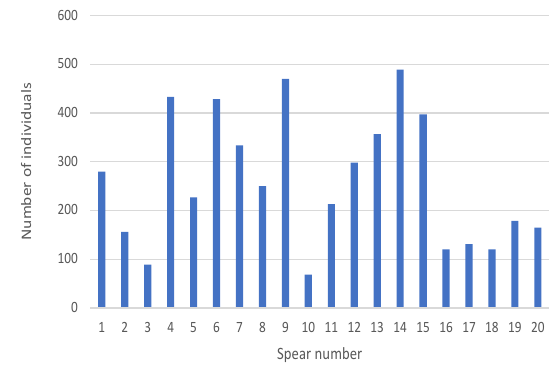
Figure 7. Average number of larvae per infested